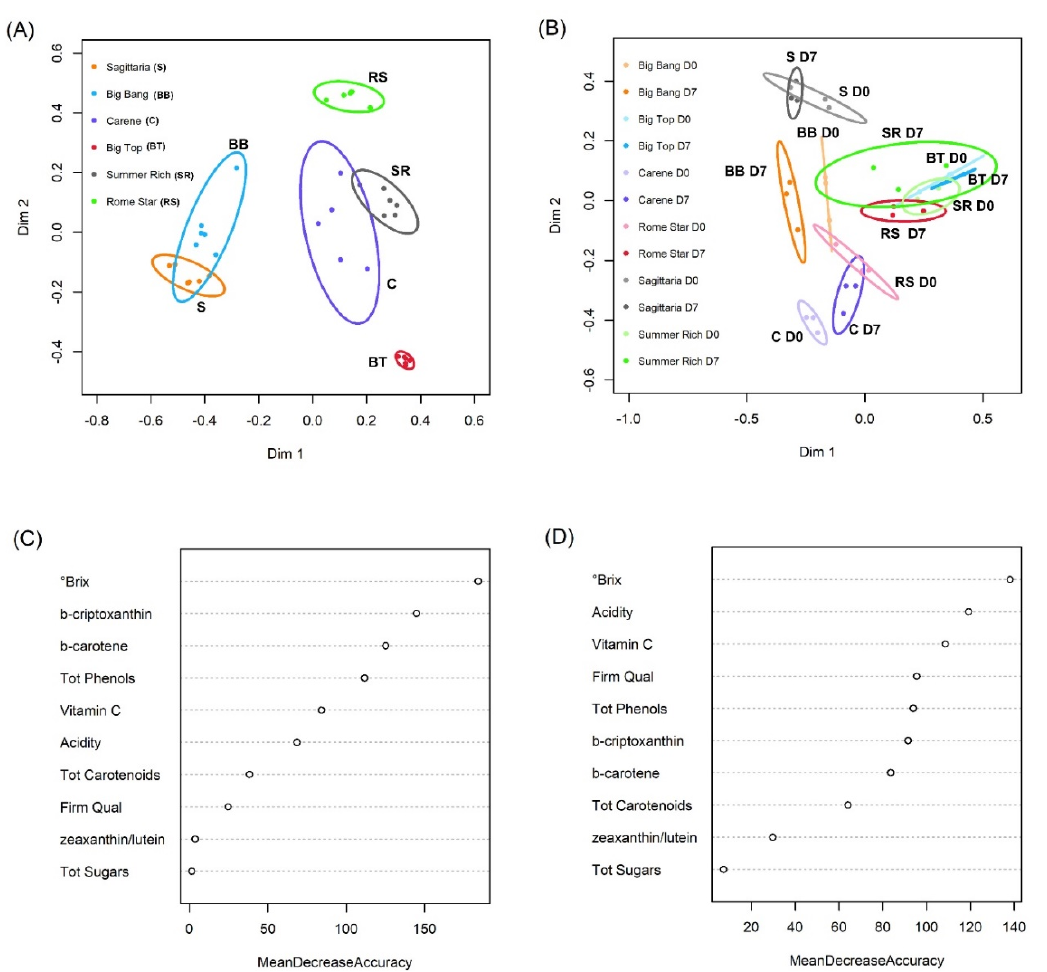
Table 2. Univariate test results from the manylm model regressing cultivar and storage treatment against peach intrinsic quality characters.